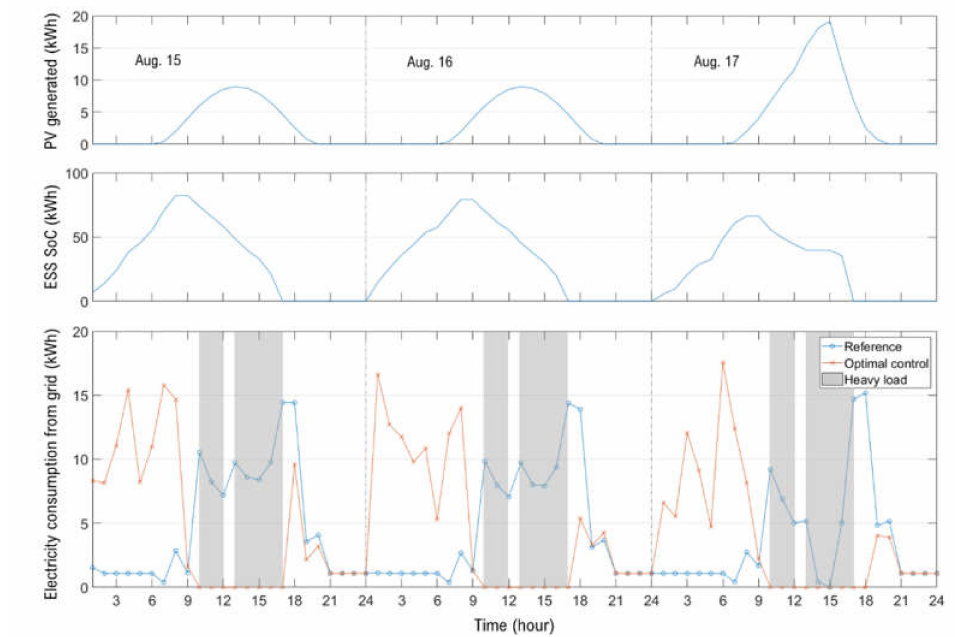
Figure 4. Optimized ESS variation (middle) and grid electricity consumption (bottom).